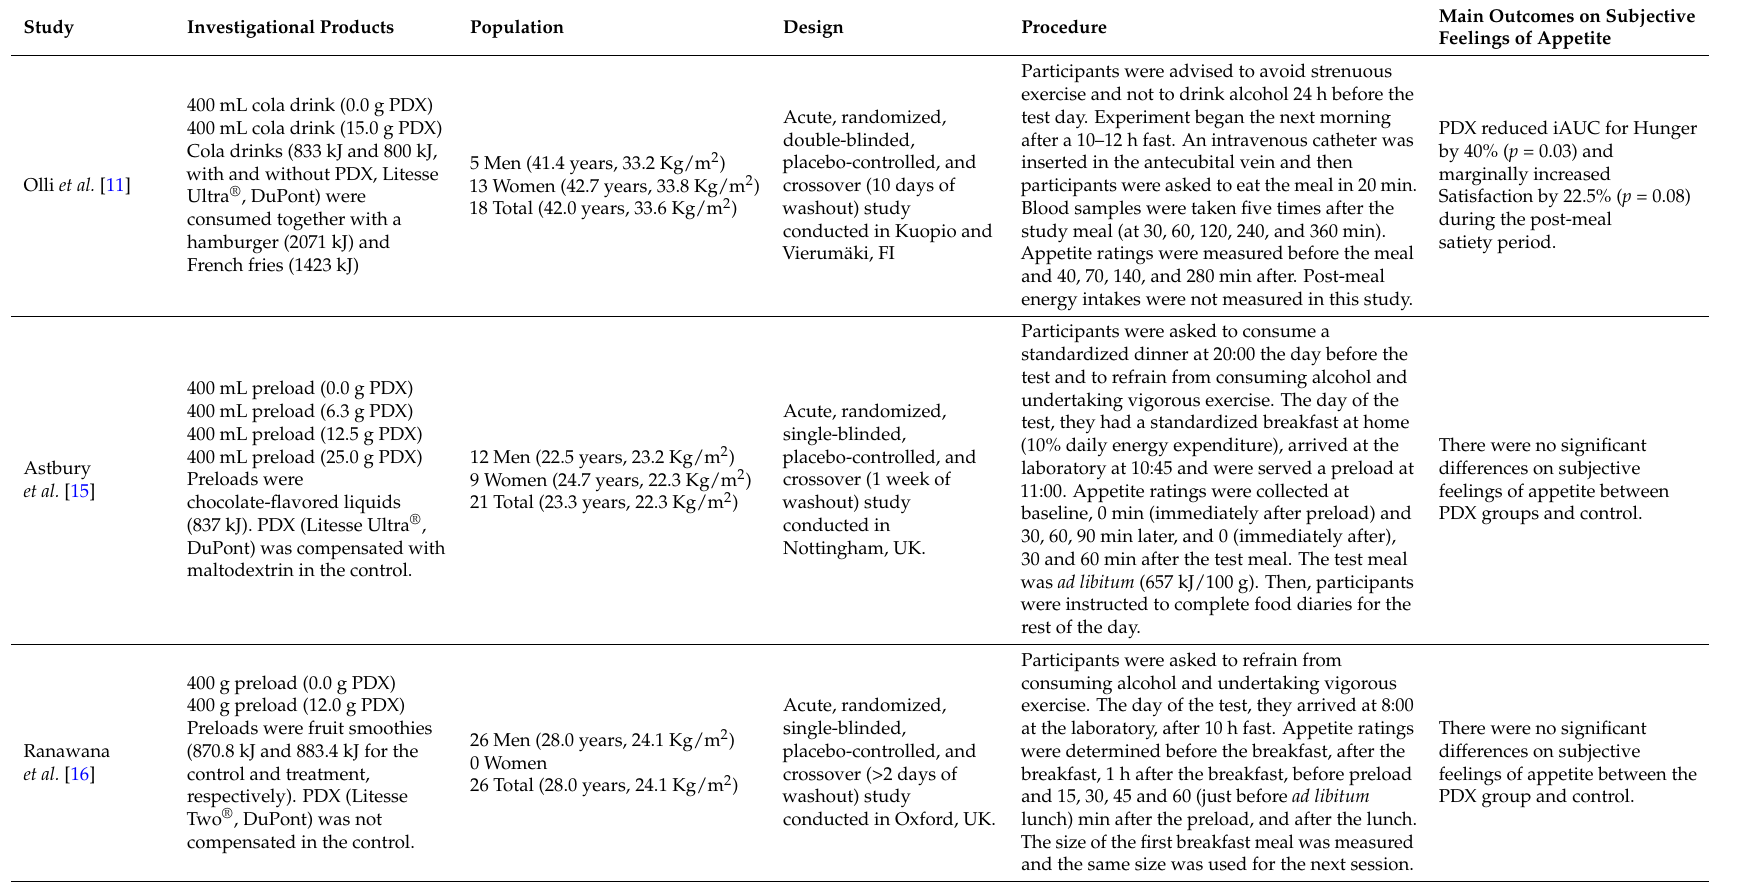
Table 1. Summary of studies included for systematic review and meta-analysis of subjective feelings of